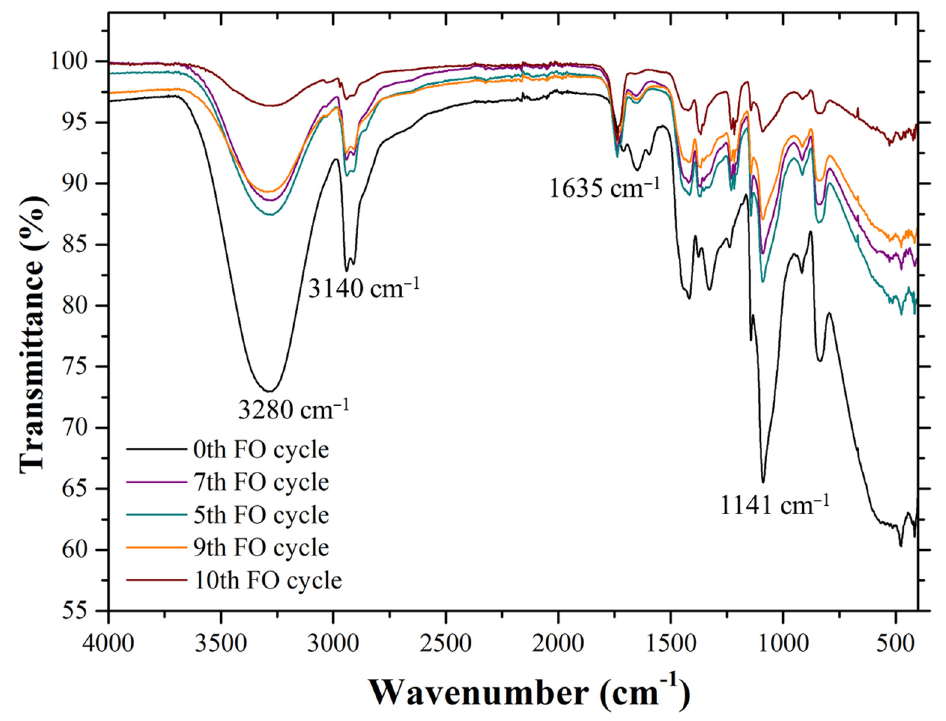
Figure 5. FTIR spectroscopy image of the synthesized hydrogel after each cycle .